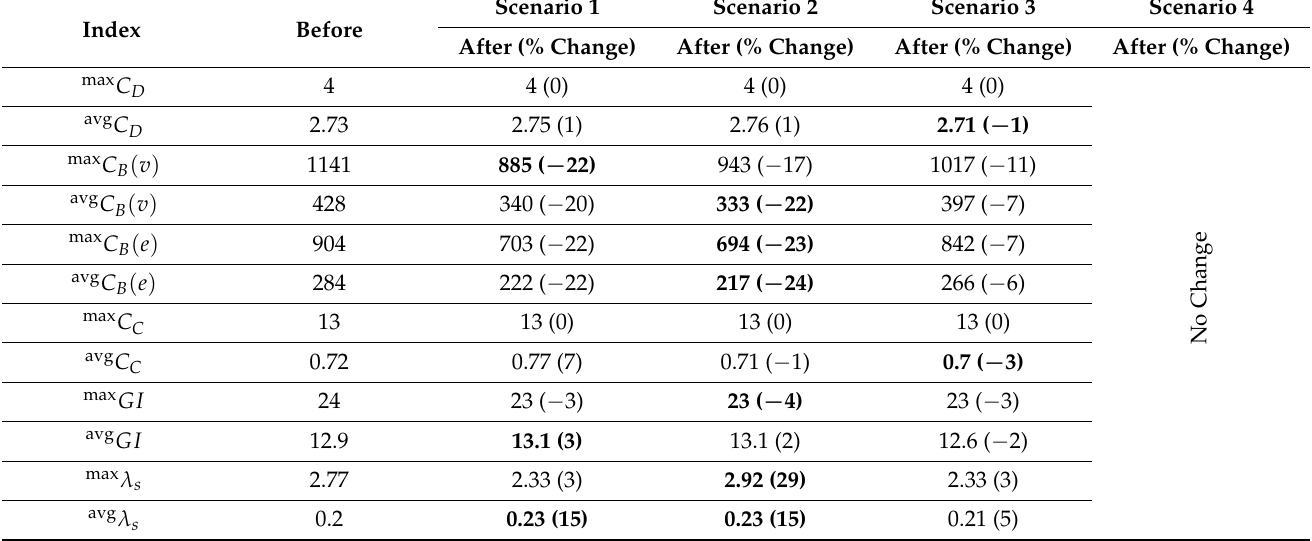
Table 12. Transportation network structural properties before and after an